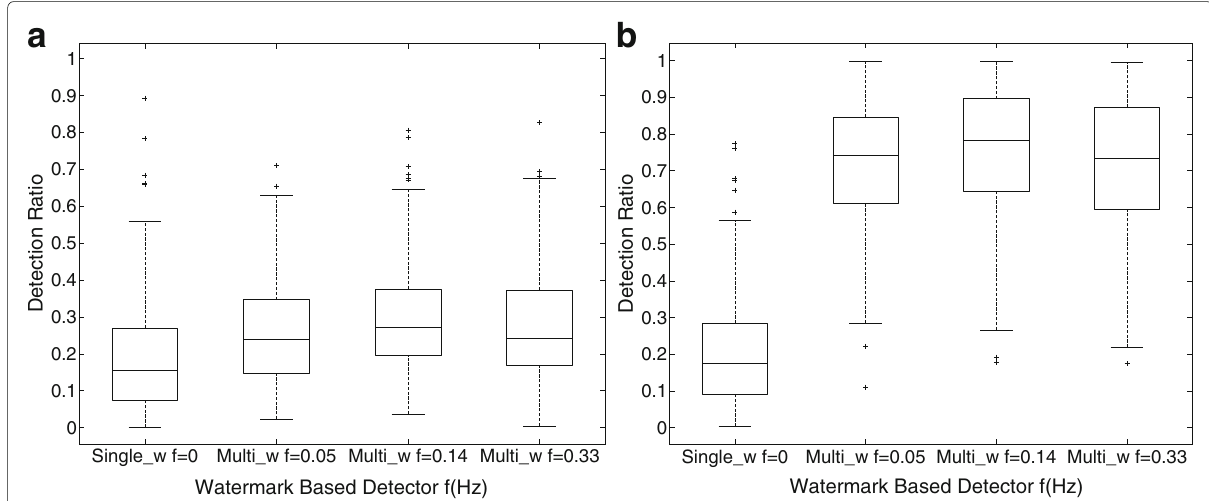
Fig. 8 Numeric simulation results using the single- and multi-watermark detection schemes with the same performance loss. a Detection ratio for a system of order four, using single- and multi-watermarks. b Detection ratio for a system of order 25, using single- and multi-watermarks. a Detection ratio function with respect to the single- and multi-watermarks with different switching frequencies for fourth order systems. b Detection ratio function with respect to the single- and multi-watermarks with different switching frequencies for systems of order 25